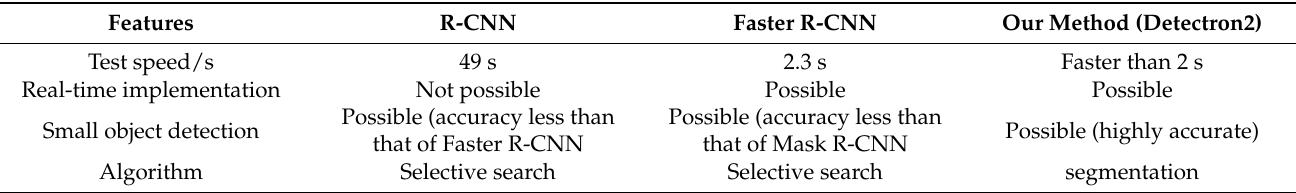
Table 6. Comparison between different models.